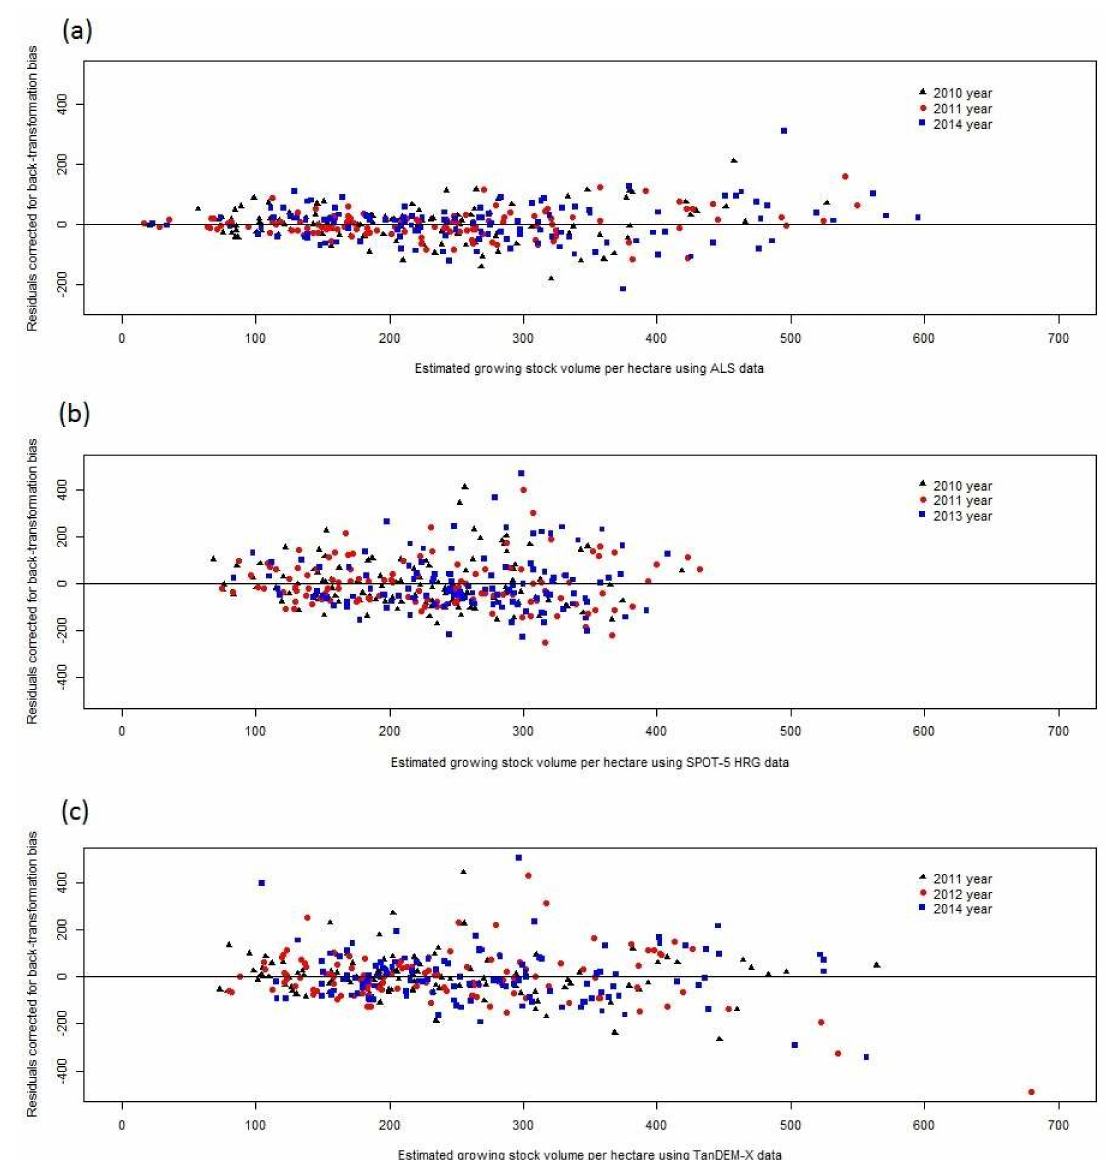
Figure A3. Estimated values versus residuals for estimated growing stock volume per hectare using ( a ) ALS data fitted to “LOG-LOG” regression models; ( b ) SPOT-5 HRG data fitted to “SEMILOG” regression model; ( c ) TanDEM-X data fitted to “SEMILOG” regression model. In all model residuals are calculated after back-transformation and corrected for bias.